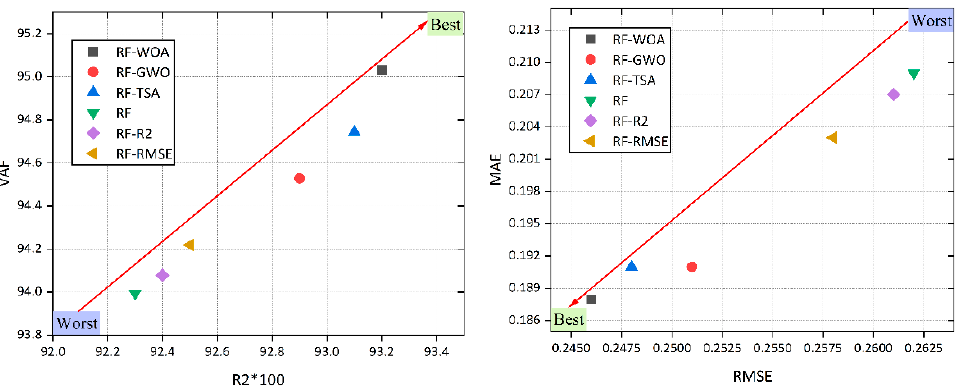
Figure 9. Results of the evaluation metrics of the developed models on the testing set.